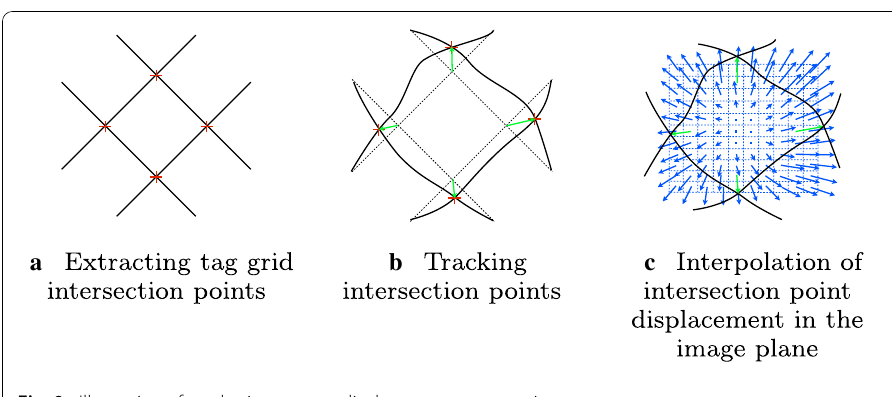
Fig. 9 Illustration of synthetic apparent displacement computation